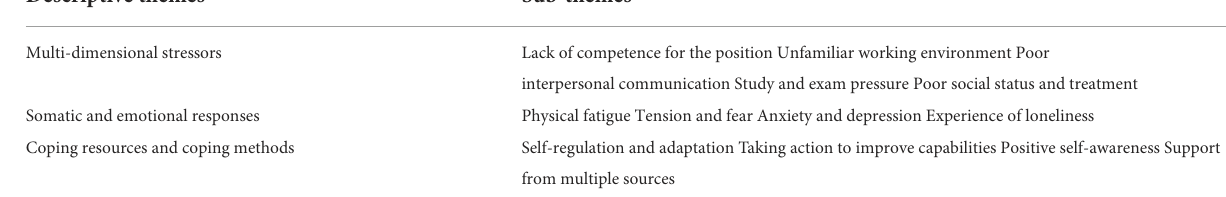
TABLE 3 Thematic synthesis